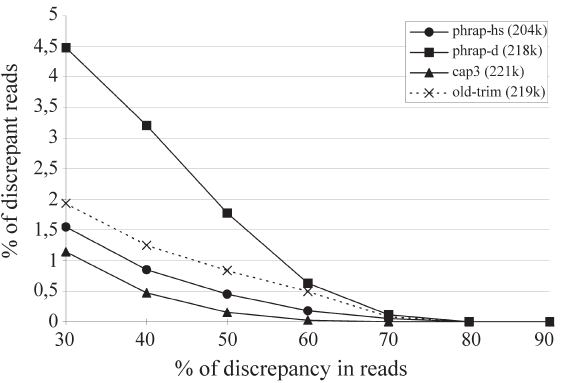
Figure 4 - Distribution of discrepant reads among the assemblies. As dis- crepant reads can only be calculated for clusters of two or more reads the number of reads belonging to such clusters in each assembly is shown in parentheses in the